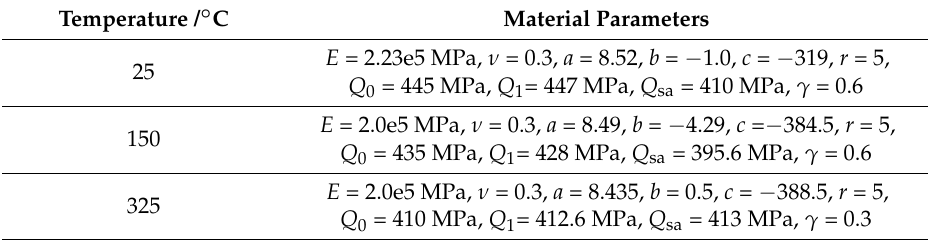
Table 1. Material parameters using in the proposed model at different